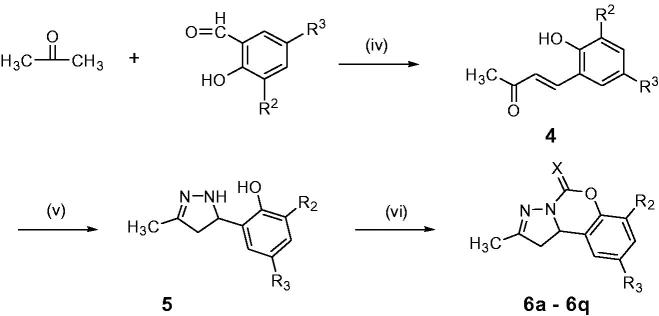
Synthesis of compounds 6a–6q. Reagents and conditions: (iv) 40% NaOH solution, 60 °C; (v) N2H4·H2O, EtOH, reflux; (vi) N,N′-carbonyldiimidazole or 1,1′-thiocarbonyldiimidazole, CH2Cl2, r.t.